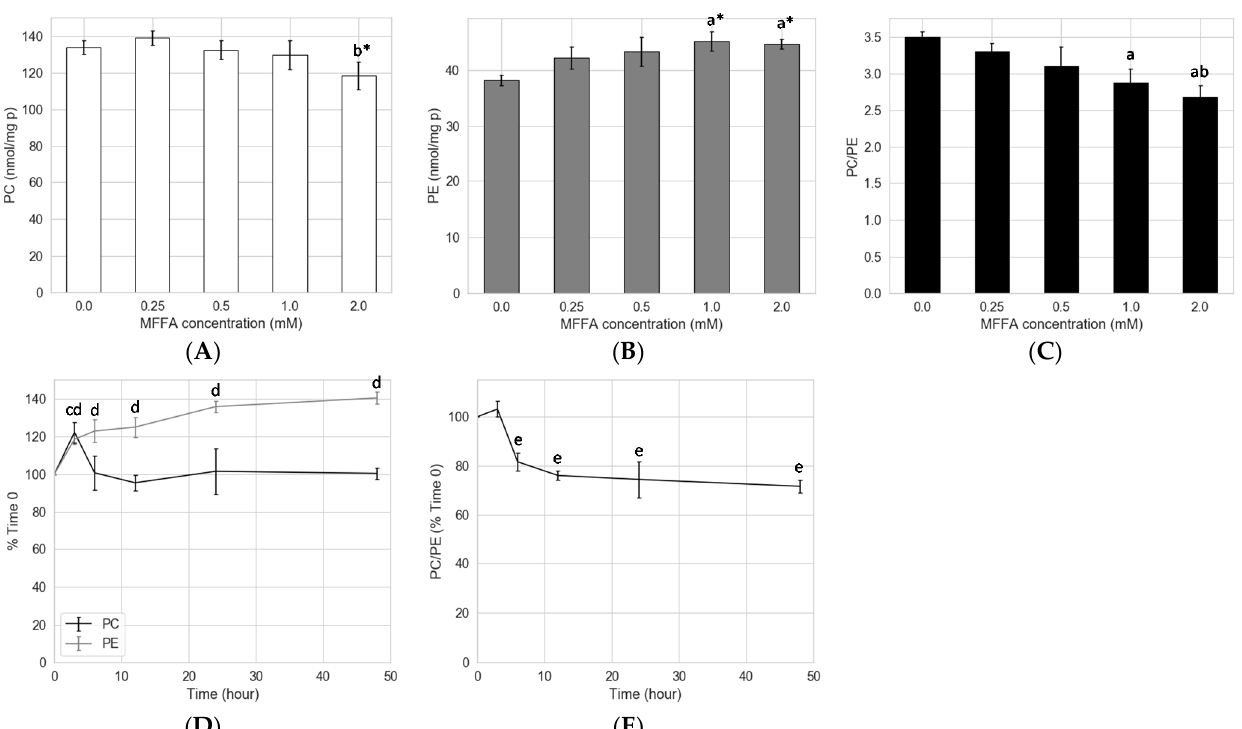
Figure 1. Effects of MFFA on hepatocyte phospholipid and PC/PE. MFFA treatments with different doses and durations were tested. Isolated rat hepatocytes were treated with 0–2 mM of MFFA for 24 h (dose effects, panel A – C ), and 2 mM of MFFA for 0–48 h (time course effects, panel D , E ). PC and PE contents (nmol/mg protein) in the cellular extracts were determined by LC-MS lipidomic analysis, and PC/PE was calculated accordingly. Data shown as mean ± sem. For dose effect experiments, a Kruskal–Wallis test was first performed followed by Mann–Whitney U tests as the post hoc analysis; for time effect experiments, Mann–Whitney U tests between control and MFFA groups at matched time points were performed; a: p < 0.05 vs. 0.0 mM group; b: p < 0.05 vs. 0.25 mM group; c: p < 0.05 vs. control group for PC at the labelled time point; d: p < 0.05 vs. control group for PE at the labelled time point; e: p < 0.05 vs. control group for PC/PE at the labelled time point. * indicates the comparison is only significant for post hoc tests, but not the Kruskal–Wallis test ( n = 4).